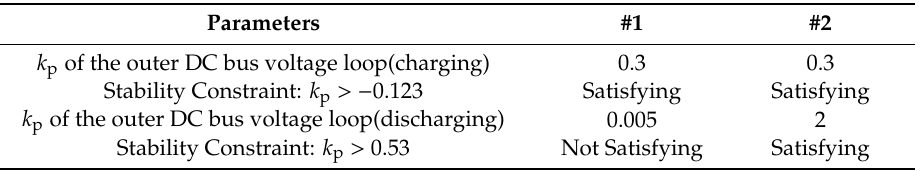
Table 3. The experiment parameters of